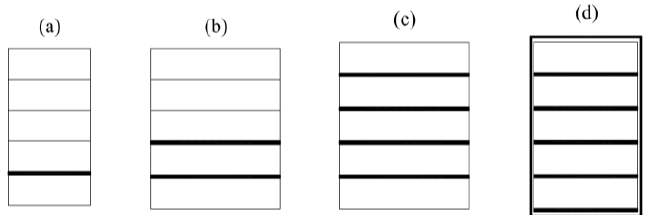
Figure 7. Methods of strengthening solid wood with FRP in different configurations—( a ) one strip, ( b ) two strips, ( c ) four strips, ( d ) four strips and around the perimeter.